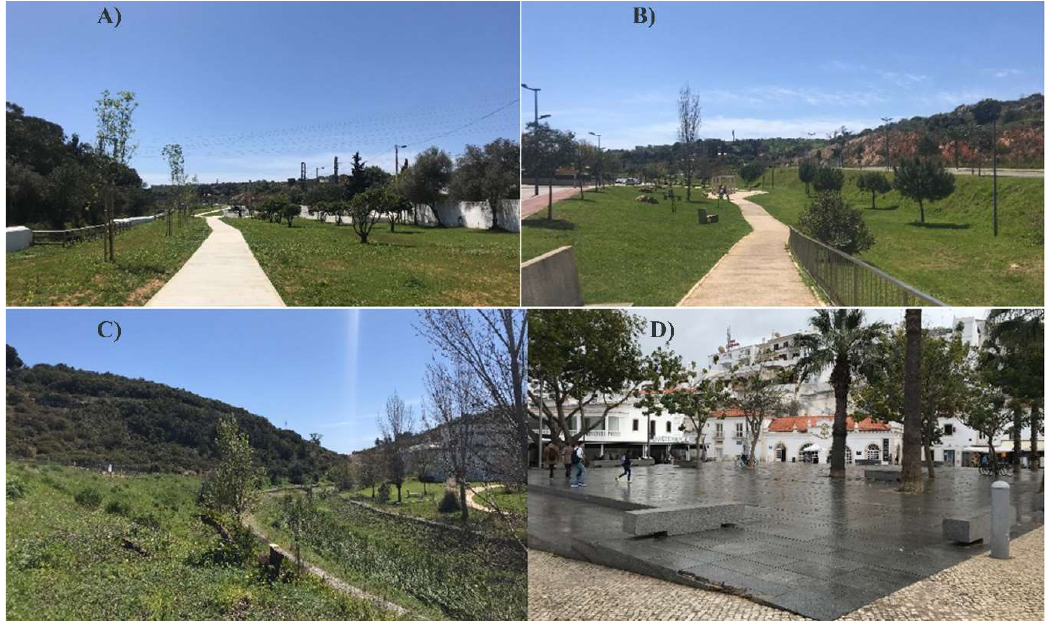
Figure 3. The four zones of the study area following the science of strolling: Area 1-backyard silence